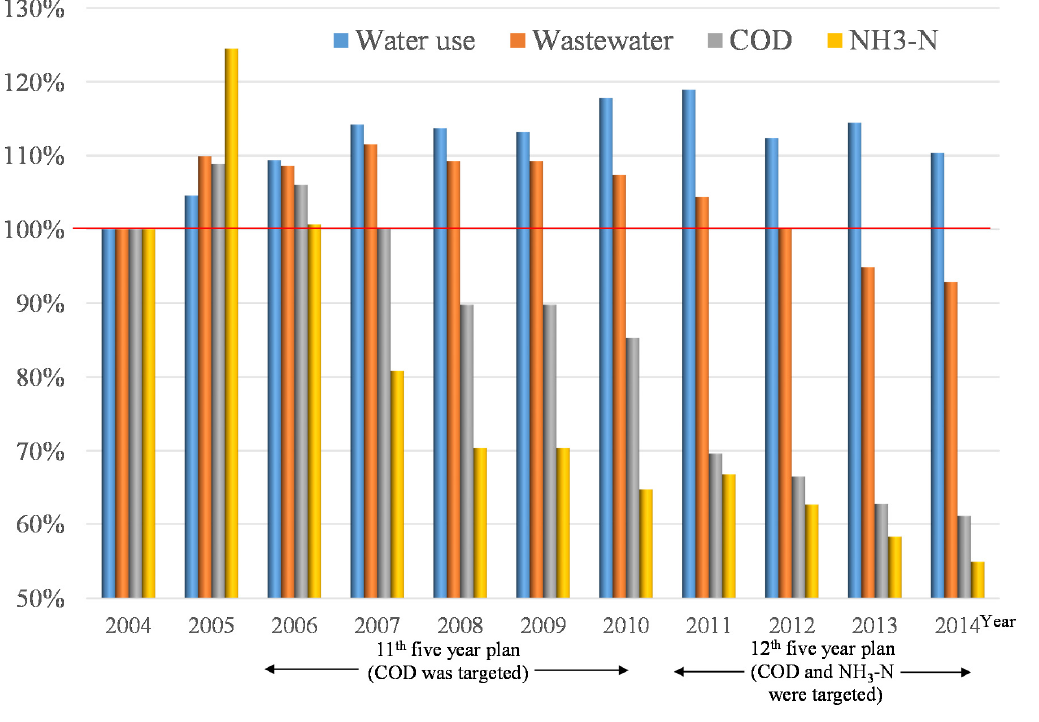
Figure 1. Changes in industrial water use, wastewater, and pollutant discharge in China. Note: The vertical axis indicates the change in each variable (year 2004 = 100%). Source: China Statistical Yearbook on the Environment [12].